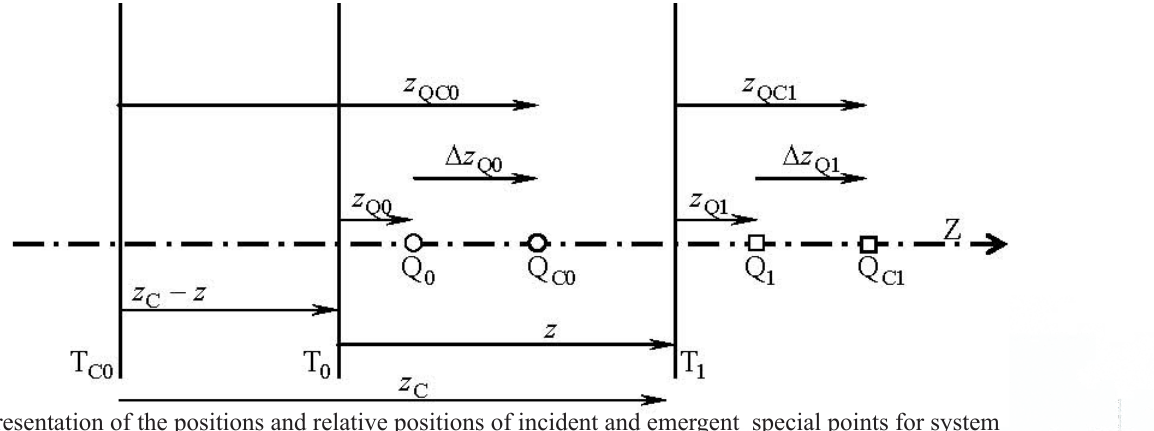
Figure 5 Representation of the positions and relative positions of incident and emergent special points for system S ( Q 0 and Q 1 ) and for combined system S C ( Q C0 and Q C1